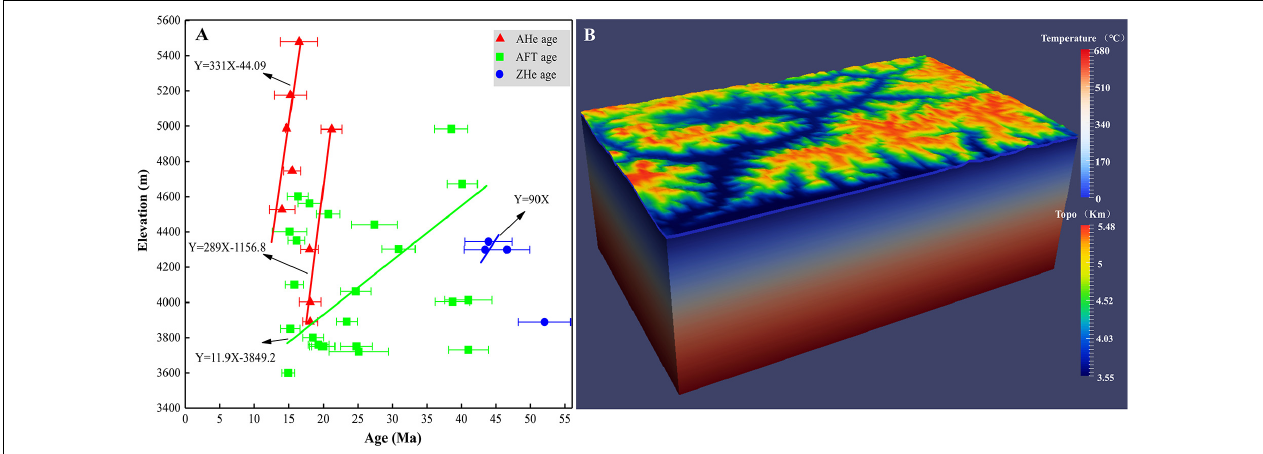
FIGURE 3 | (A) Denudation rates estimated from the age–elevation relationship from the Lhasa River drainage according to least-square fitting. (B) Model setup for the 3D thermokinematic model (parameters are given in Table 2 ). The model calculates the evolving thermal field of a 50-km-thick crustal block using a combination of geothermal, rock denudation, and landscape evolution